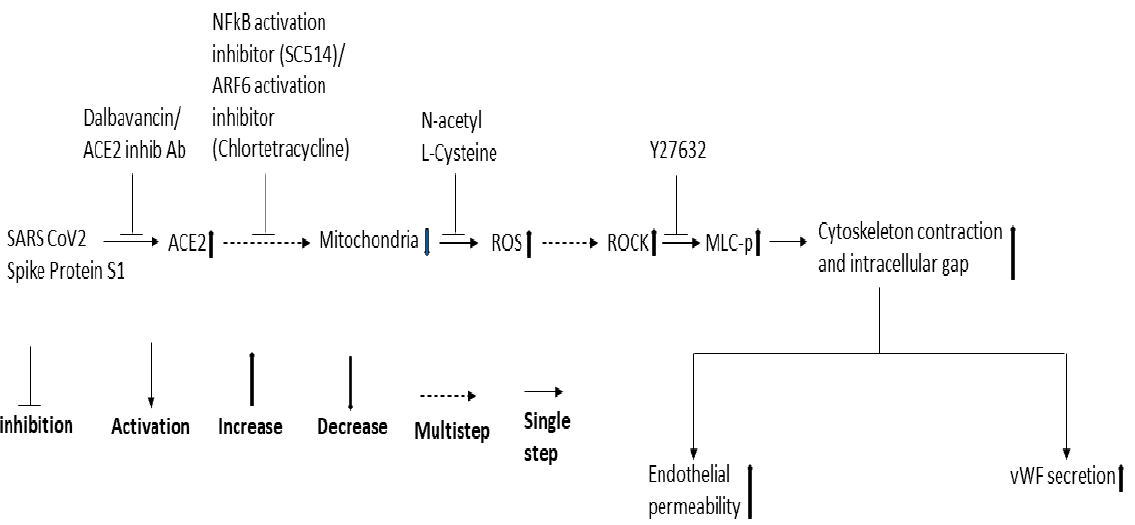
Figure 8. Proposed schematic representation of the signaling cascade downstream of ACE2 for SARS-CoV-2 spike protein-induced EC permeability and its vWF secretion.